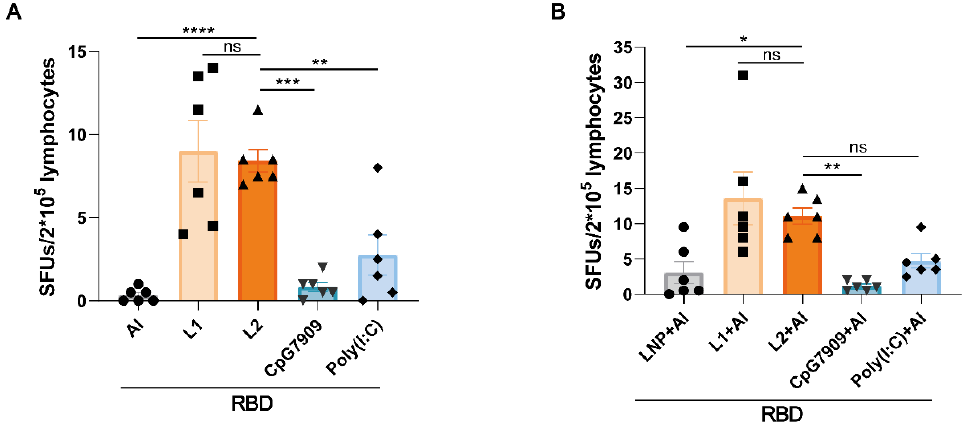
Figure 7. L2 and L2 + Al increased the levels of RBD-specific T-cell secreted IFN- γ immune response induced by the recombinant protein vaccine in mice. ( A ) The RBD-specific T cells secreted IFN- γ in RBD + Al, RBD + L1, RBD + L2, RBD + CpG 7909, and RBD + Poly(I:C) at 14 days after the 2nd immunization. ( B ) The spike-specific T cells secreted IFN- γ in RBD + LNP + Al, RBD + L1 + Al, RBD + L2 + Al, RBD + CpG7909 + Al, and RBD + Poly(I:C) + Al groups at 14 days after the 2nd immunization. * p < 0.05. ** p < 0.01. *** p < 0.001. **** p < 0.0001. n = 6 for each group.